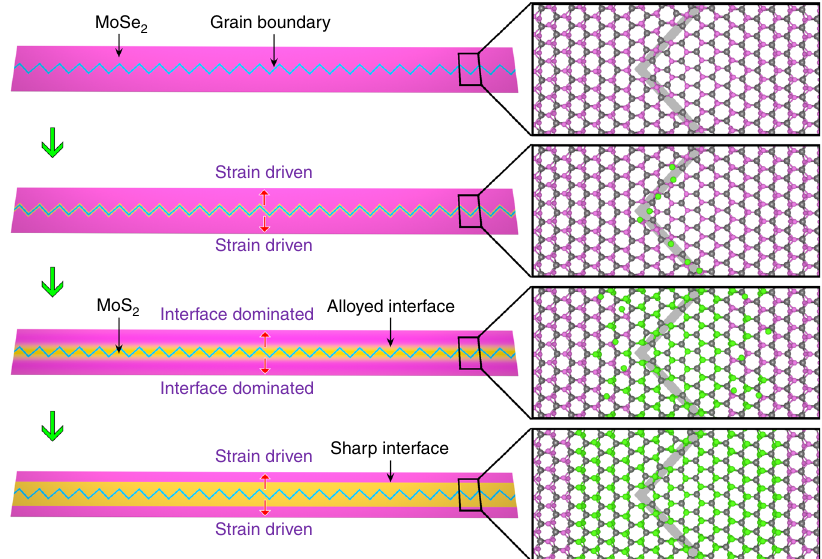
Fig. 1 Formation of ultra-long MoS 2 nano-channels. Schematic of growth steps of MoS 2 channels: (I) MoSe 2 monolayer with intrinsic 4|8 GBs is produced; (II) sulfur atoms are adsorbed and then nucleation happens due to the strain at GBs; (III) Se atoms are continuously substituted by S atoms from GBs to nearby area to form alloyed regions, and afterward the growth is dominated by interface energy; and (IV) MoS 2 channels with sharp interface form, and eventually the growth is sustained by the strain again to widen the